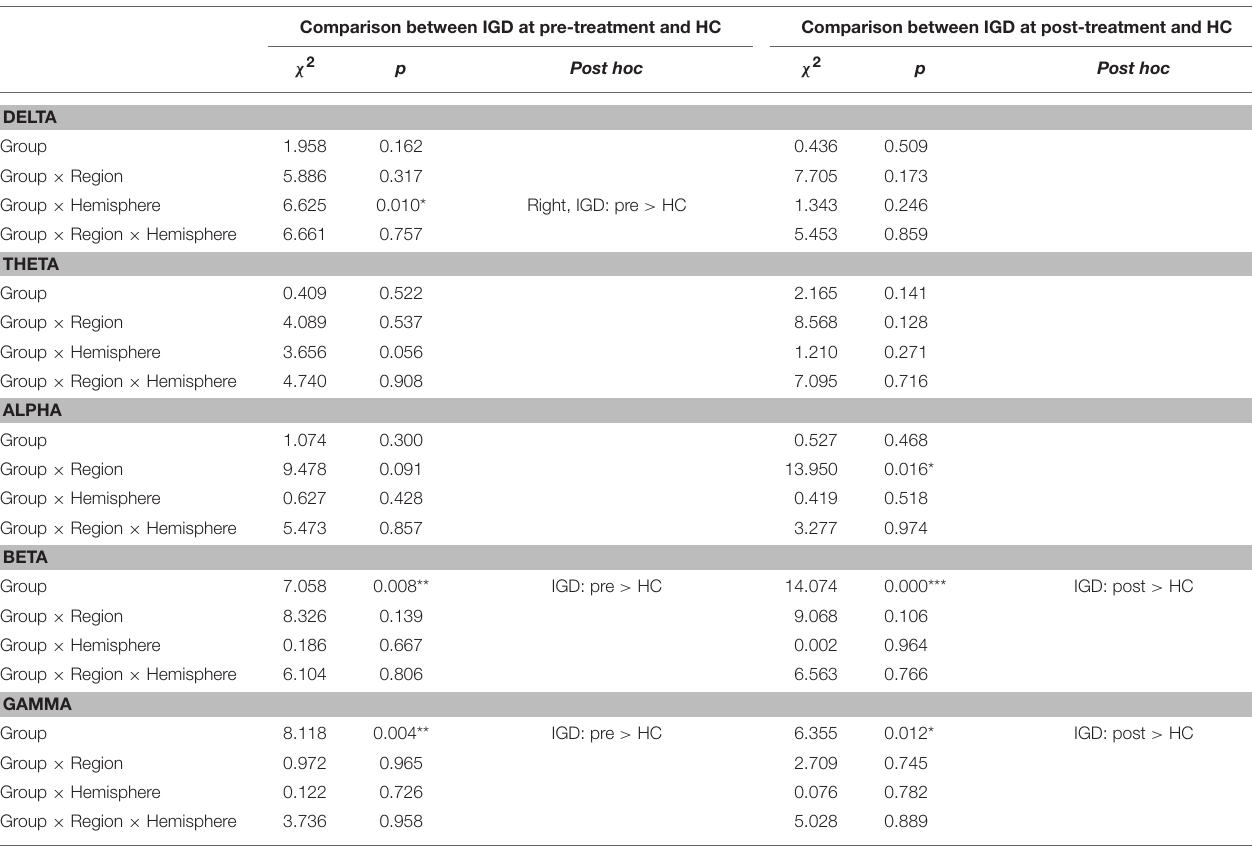
TABLE 3 | Effects on EEG intrahemispheric coherence controlling for the effects of demographic (education) and psychological (scores on the BDI-II, BAI, and BIS-11) characteristics before and after treatment. Comparison between IGD at pre-treatment and HC Comparison between IGD at post-treatment and HC